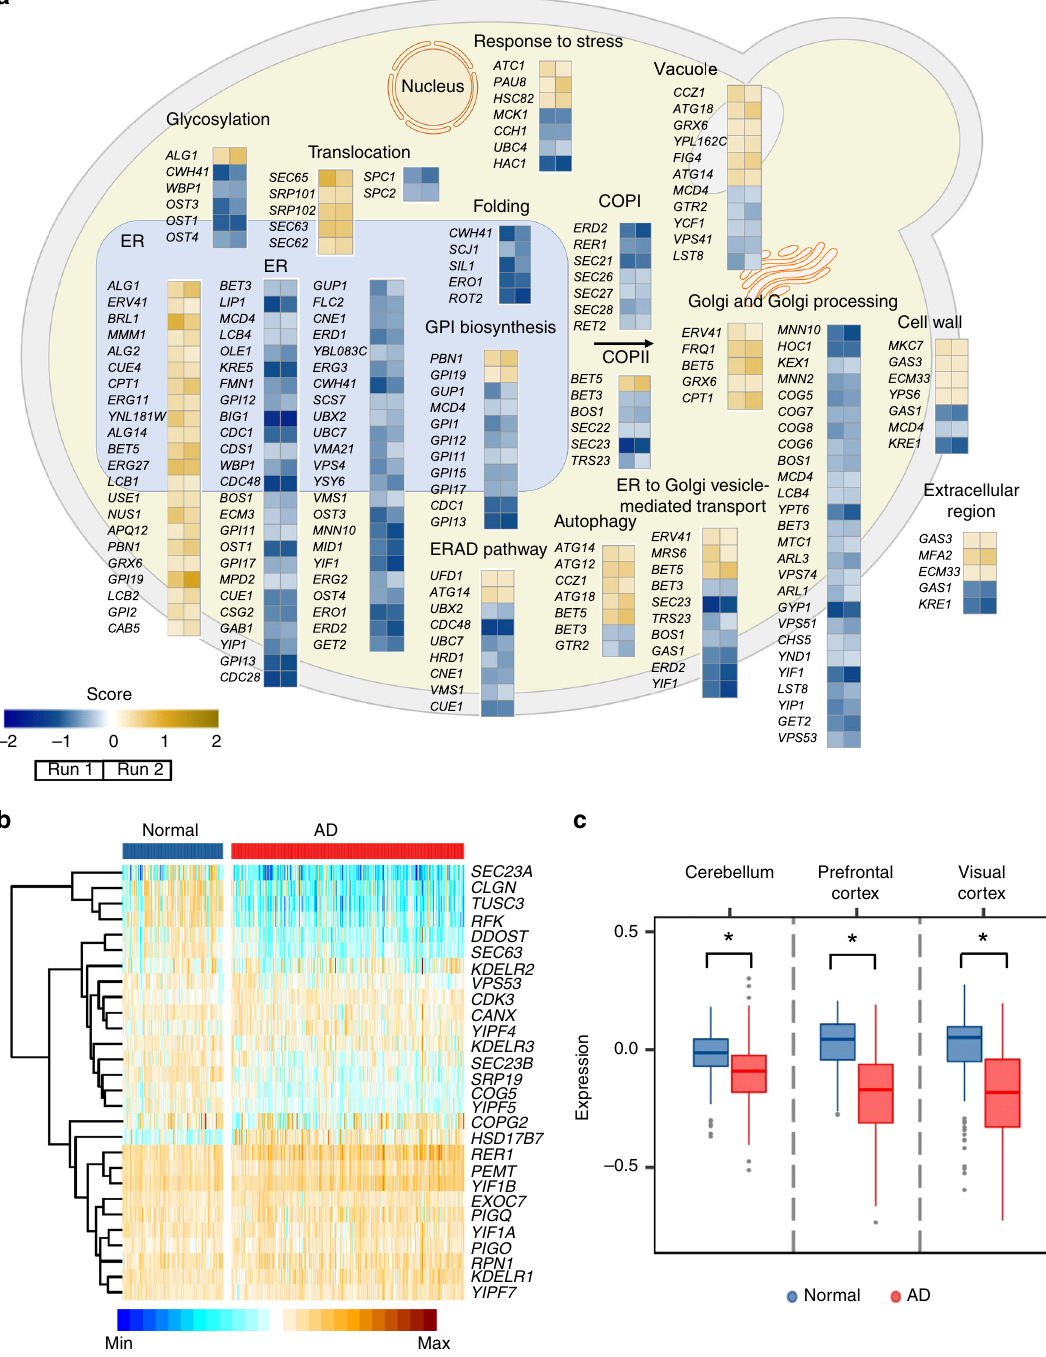
Fig. 2 Roles of protein secretion and degradation processes in A β 42 toxicity. a Mutants with signi fi cantly changed A β 42 toxicity mapped to protein secretory and degradation processes ( p -adj < 0.05 and score ≥ 0.2 or ≤ − 0.2). b The mRNA expression levels of 28 human orthologs in the prefrontal cortex of Alzheimer ’ s disease (AD) patients versus normal controls. Genes were ranked according to the size of their signi fi cant difference between the two groups. Out of the 28 human orthologs, 22 (79%) showed signi fi cantly changed mRNA levels ( p -adj < 0.05). c Comparison of human RFK (ortholog of yeast FMN1 ) mRNA levels in three different brain regions (cerebellum, prefrontal cortex and visual cortex) between AD patients and normal controls. Asterisks (*) indicate signi fi cant differences ( p -adj <